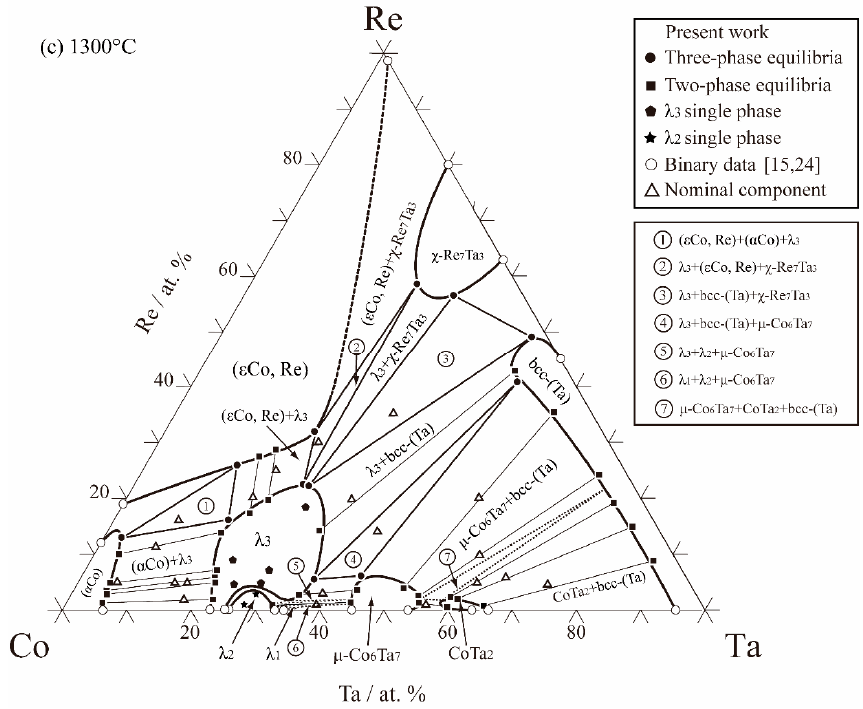
Figure 5. Experimentally determined isothermal section of the Co-Re-Ta system: ( a ) 1100 °C, ( b ) 1200 °C, ( c ) 1300 °C.